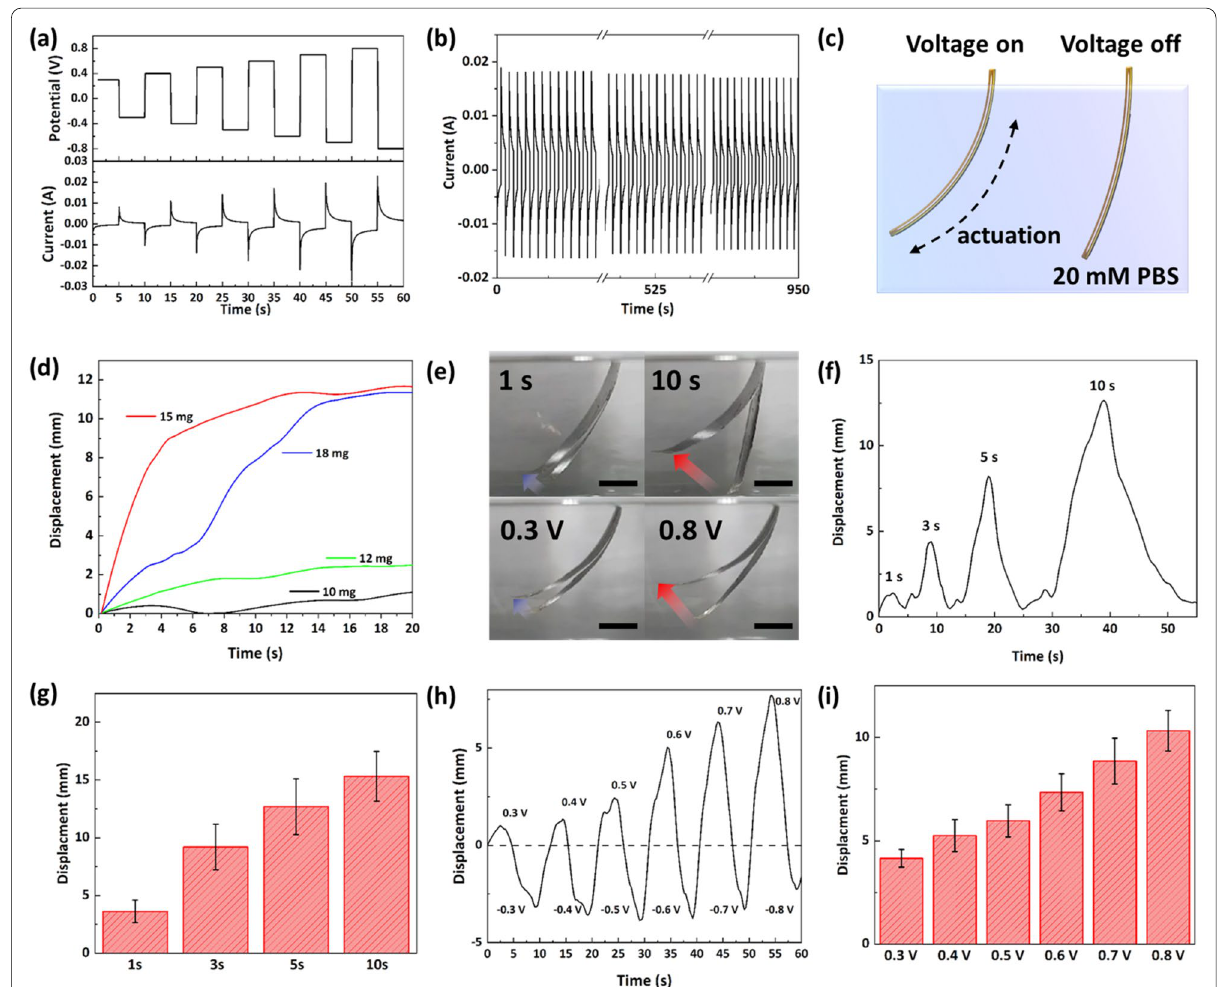
Fig. 3 Confirmation of actuator motion performance. a variation of current value with applied potential. b cycling stability of MoS 2 NS‑modified Au‑coated PI electrode. c schematic diagram of actuation of MoS 2 NS‑modified Au‑coated PI electrode in 20 mM PBS. d displacement of MoS 2 NS‑modified Au‑coated PI electrode of different weight of MoS 2 NSs. e optical images of actuation in forward direction at 1 s, 10 s, 0.3 and 0.8 V (Scale bar 5 mm). f , g displacement of MoS 2 NS‑modified Au‑coated PI electrode with diverse time (1, 3, 5, 10 s). h , i displacement of MoS 2 = NS‑modified Au‑coated PI electrode with diverse potential